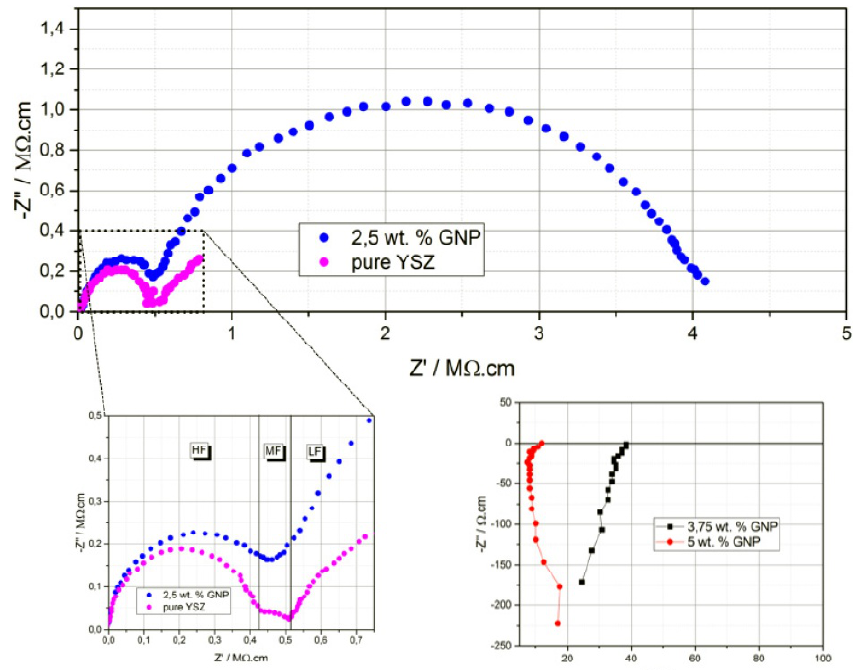
Fig. 8. Electrochemical impedance spectra of the electrochemical impedance for YSZ-GNP samples: (a) 2.5 wt.% GNP, (b) 3.75 wt.% GNP, and (c) 5.0 wt.% GNP, replotted from